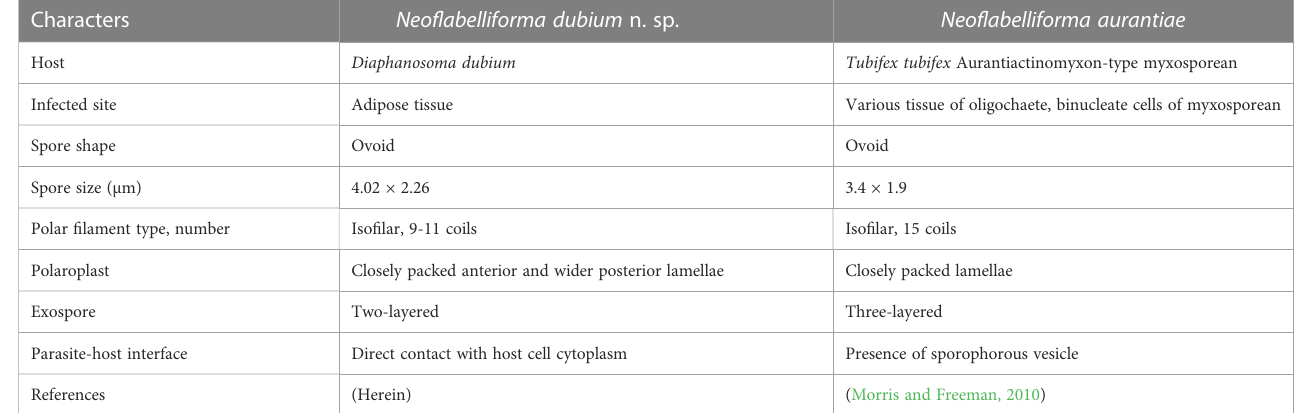
TABLE 7 Morphological comparison of Neo fl abelliforma dubium n. sp. with Neo fl abelliforma aurantiae.